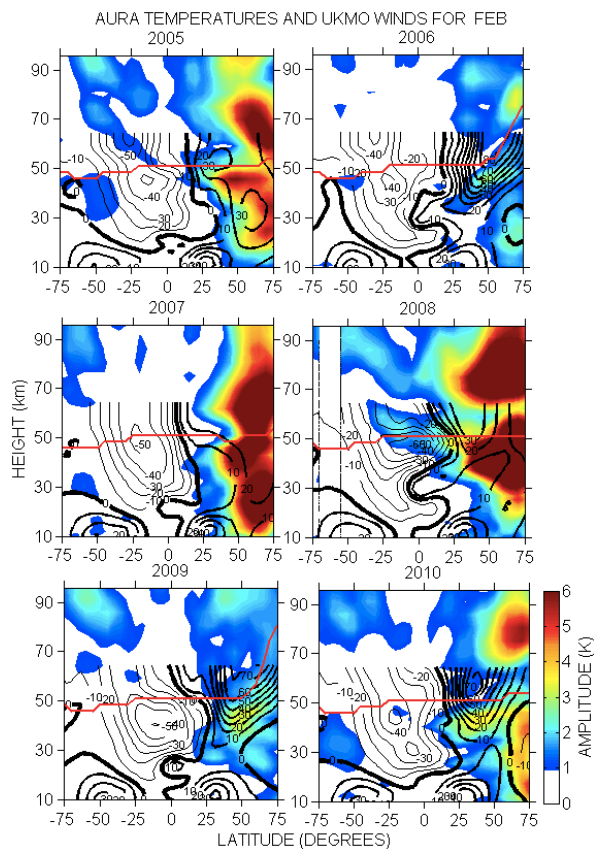
Fig. 14. Monthly-mean Aura temperature amplitudes for post Northern Hemisphere major SSW’s, February 2005–2010. Also plotted are the UKMO composite monthly-mean zonal winds (ms − 1 ) as contour lines and the stratopause height as a red con- tour